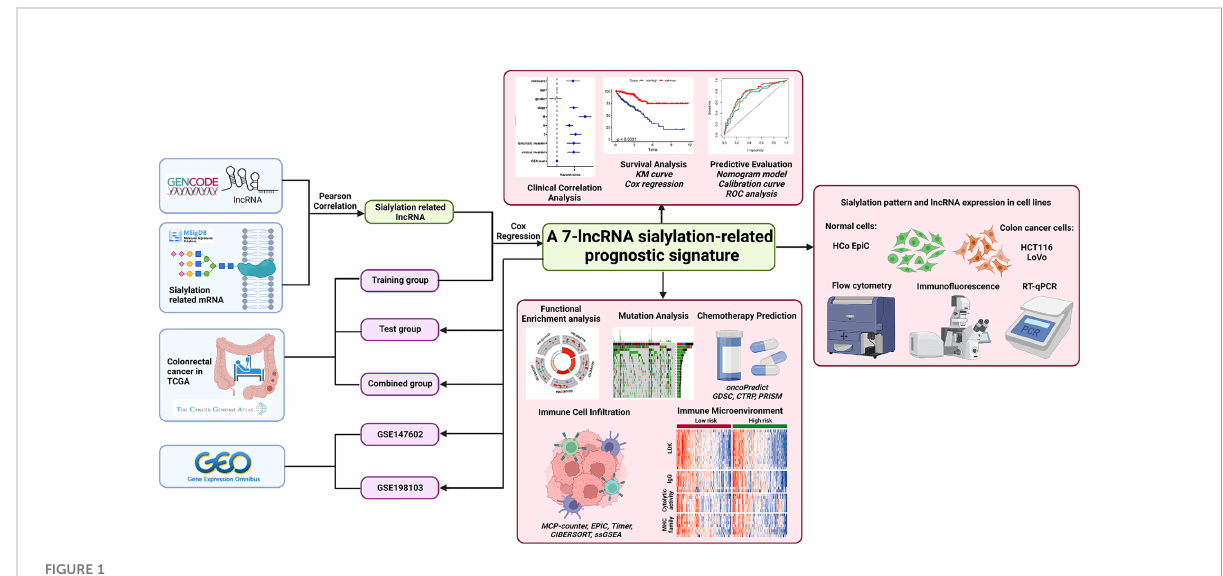
FIGURE 1 Flowchart of this